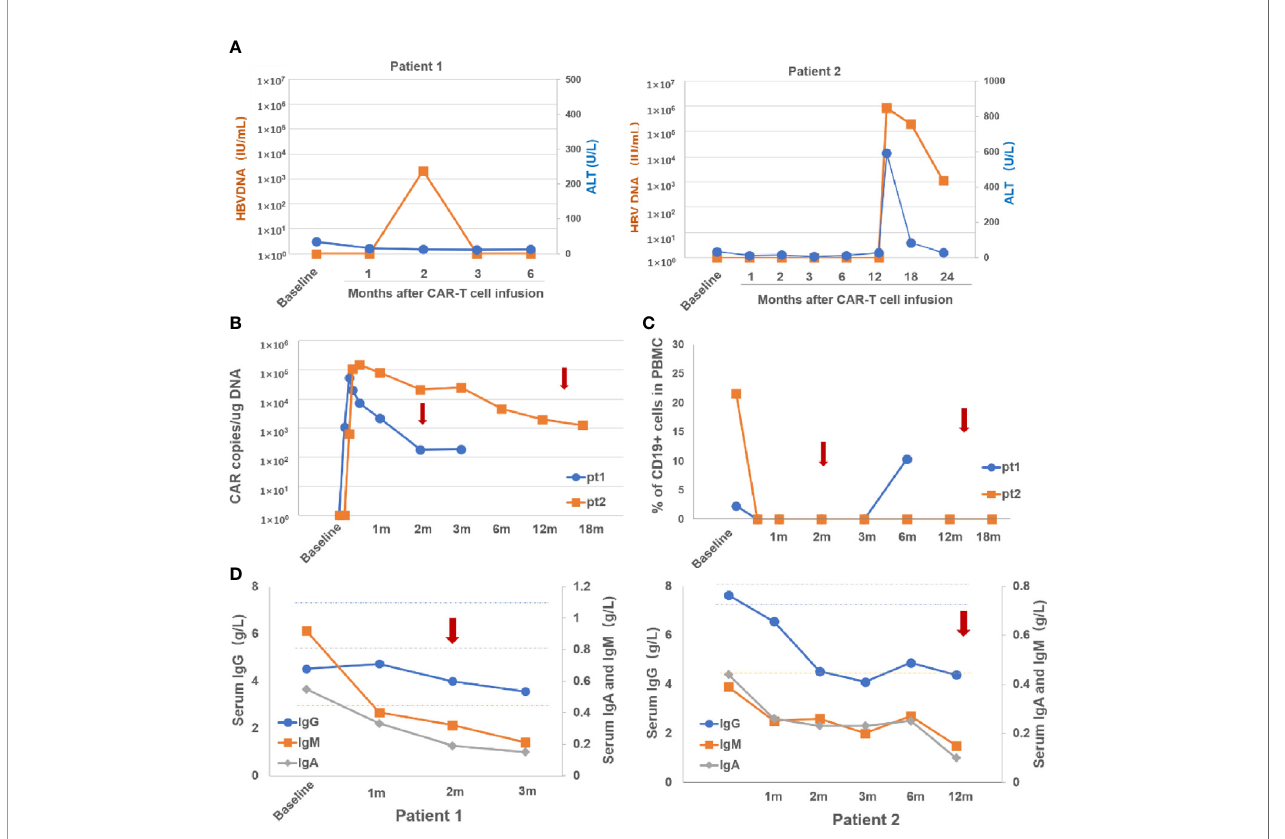
FIGURE 2 | Dynamic changes o fHBVDNA and ALT (A) , CARcopies/ug DNA (B) , percentage of CD19+ Bcells in PBMC (C) and serum levels of IgG, IgA and IgM (D) after CAR-Tcell infusion in the two patients with HBV reactivation. Arrows indicate the time at HBV reactivation in the two patients. m, month; pt, patient; PBMC, peripheral blood mononuclear cells; Ig,